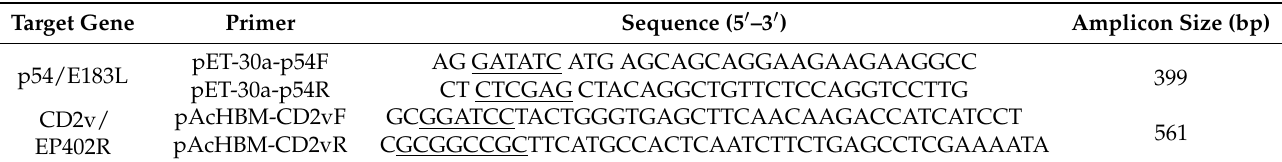
Table 1. The sequence of primers used for PCR amplification of p54 and